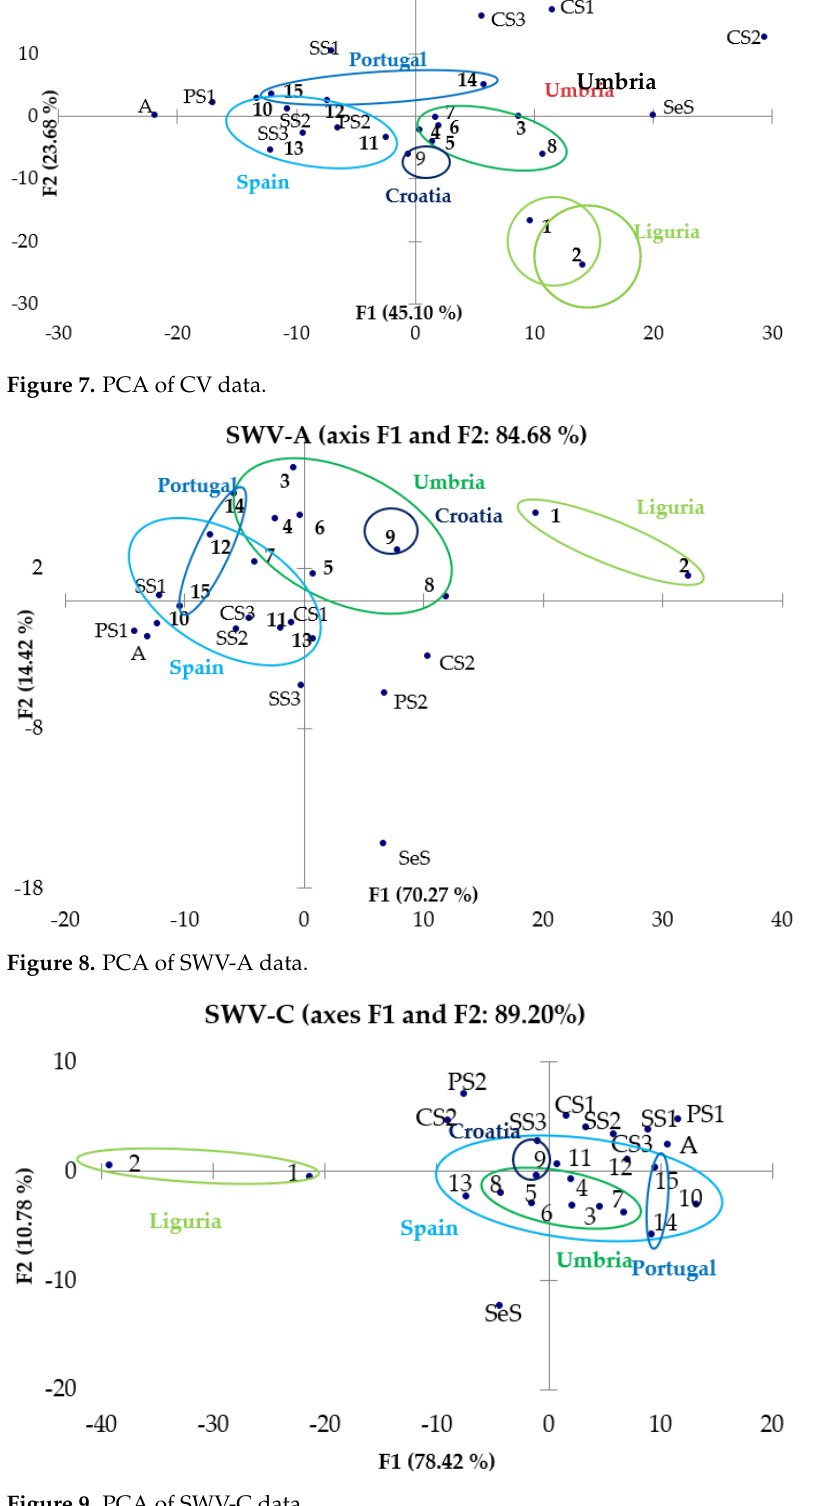
Figure 9. PCA of SWV-C data.